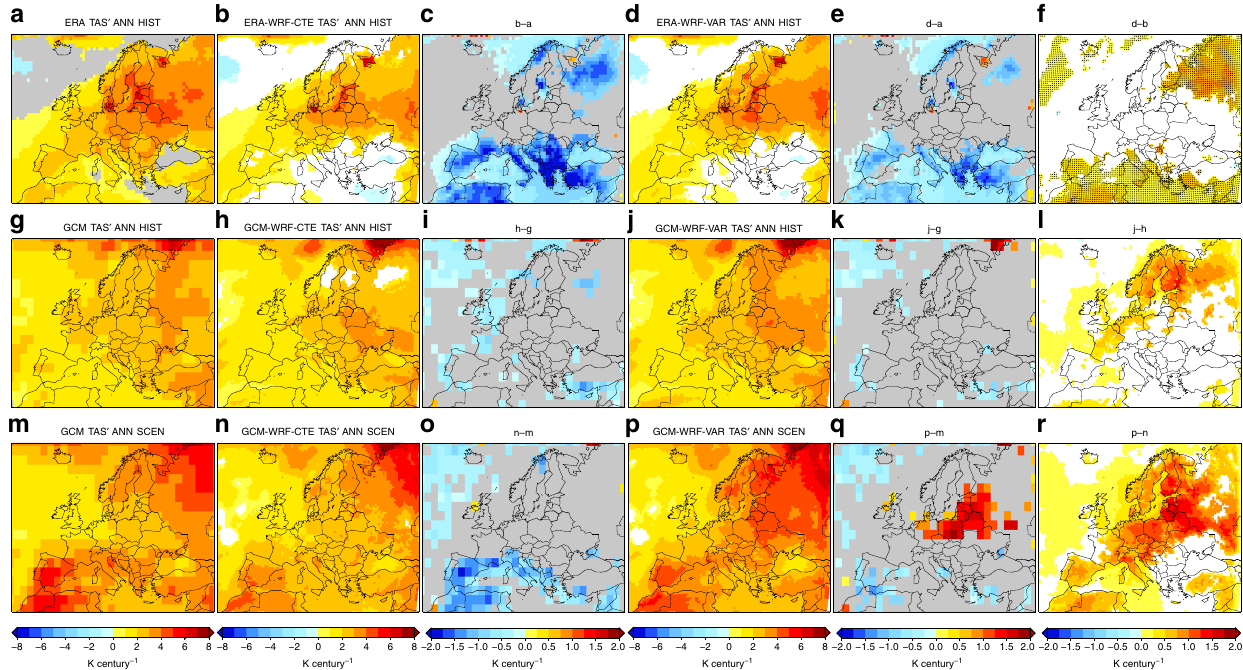
Fig. 1 Near-surface air temperature trends from global datasets and regional simulations. Trends of the simulated yearly-mean time series of TAS in the historical period 1951 – 2005 ( fi rst and second rows) and the scenario period 2006 – 2050 (third row). The fi rst row depicts the results from ERA ( a ) and ERA-driven WRF experiments (CTRL con fi guration, see Table 1), CTE ( b ) and VAR ( d ), along with the differences between ones and others: CTE minus ERA ( c ), VAR minus ERA ( e ), and VAR minus CTE ( f ). Similarly, the second and third rows ( g – r ) depict the results from GCM and GCM-driven WRF experiments. Only signi fi cant values ( p < 0.1) are shown. The points in the last column indicate that the magnitude of the difference between the VAR and CTE experiments is equal to or greater than the magnitude of the signal from the respective CTE experiment. Units: K century − 1